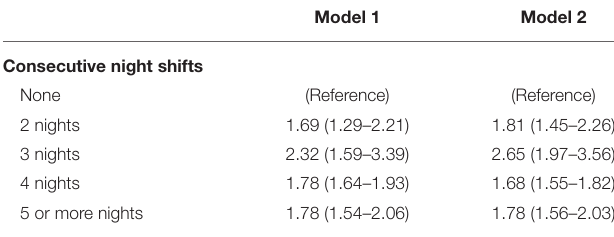
TABLE 2 | Pooled odds ratios of insomnia in multivariable logistic regression models.